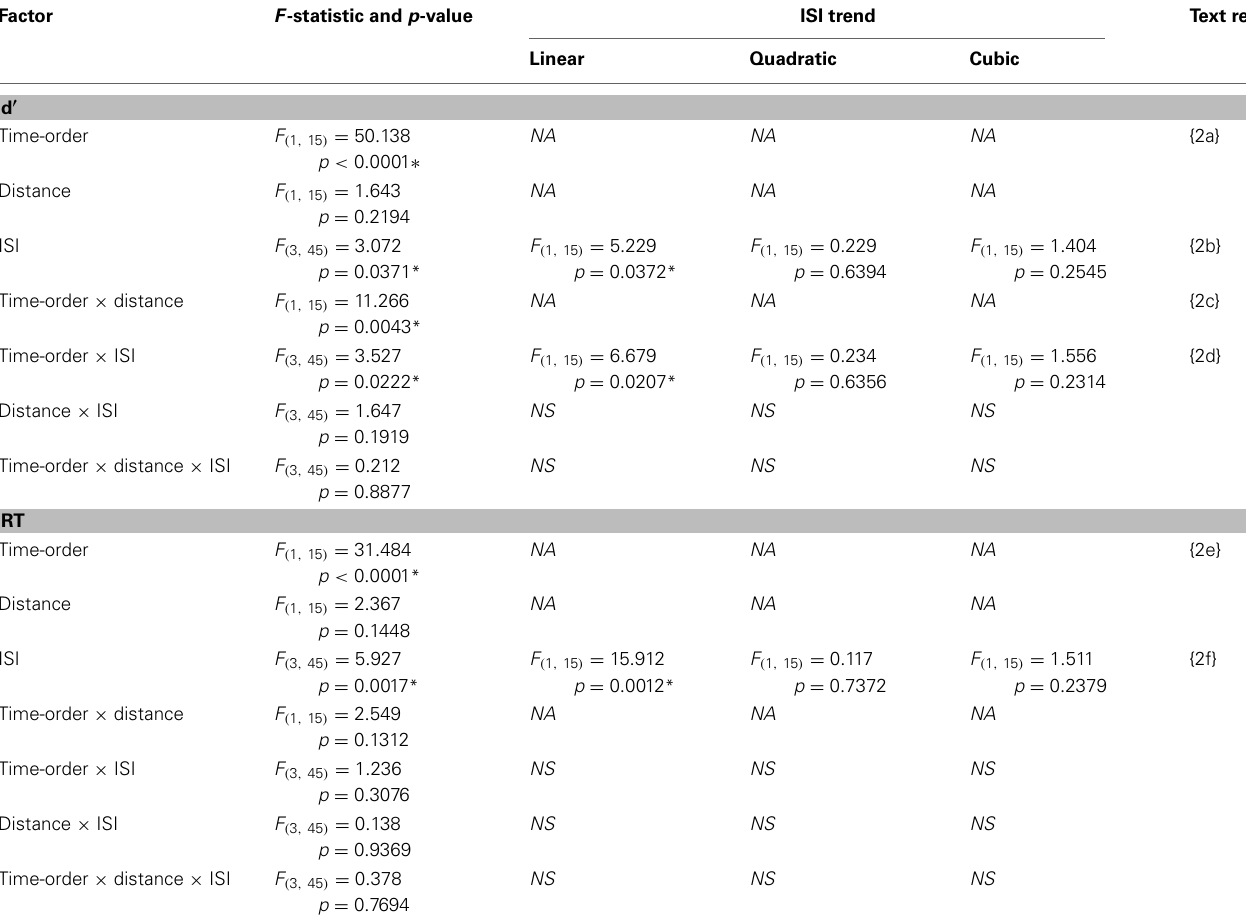
Table 2 | Experiment 2 accuracy (d (cid:2) ) and response time (RT) statistics of the time-order × distance × ISI repeated measures ANOVA. Factor F -statistic and p -value ISI trend Text ref. Linear Quadratic